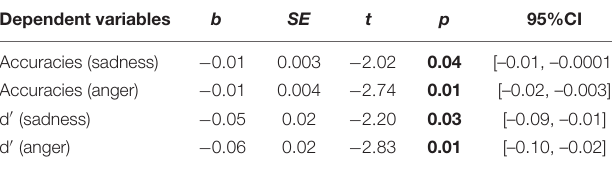
TABLE 5 | The interaction effects of group × state anxiety in the delayed-match-to-sample (DMTS) task.